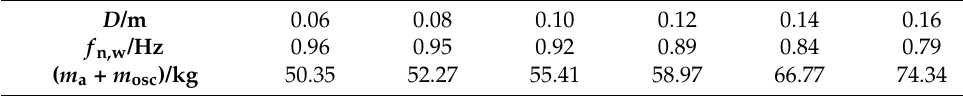
Table 4. Results of free decay tests in the water.